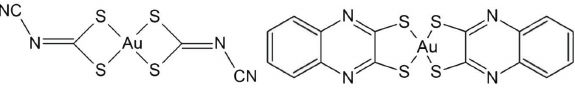
Figure 4 Binding of silver with thiol groups